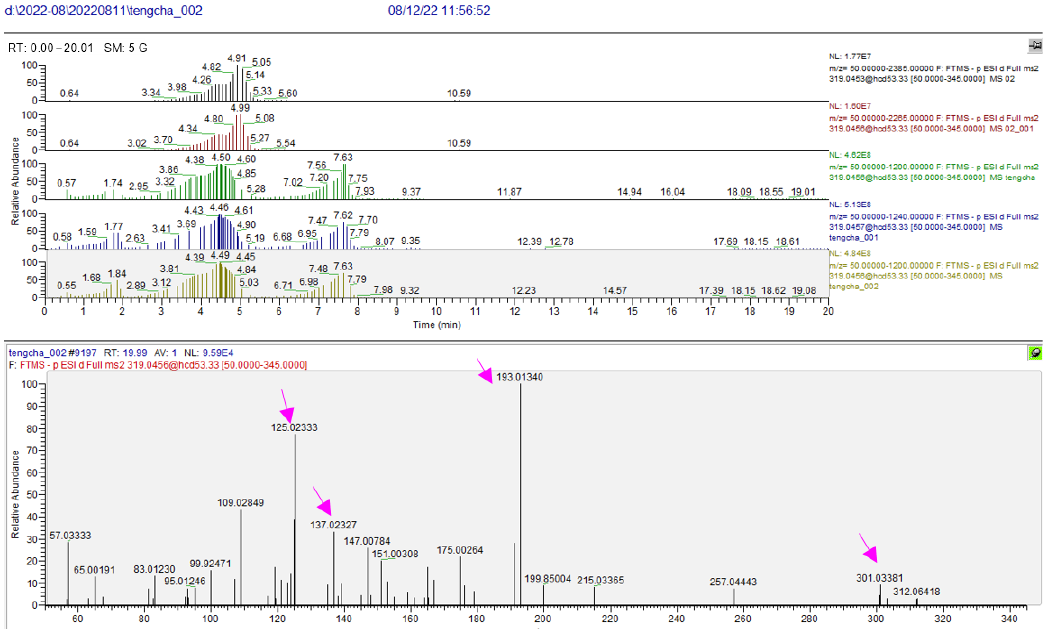
Figure 4. The typical chromatographic profile of standard ampelopsin ( upper ) and its MS/MS fragments ( below ).